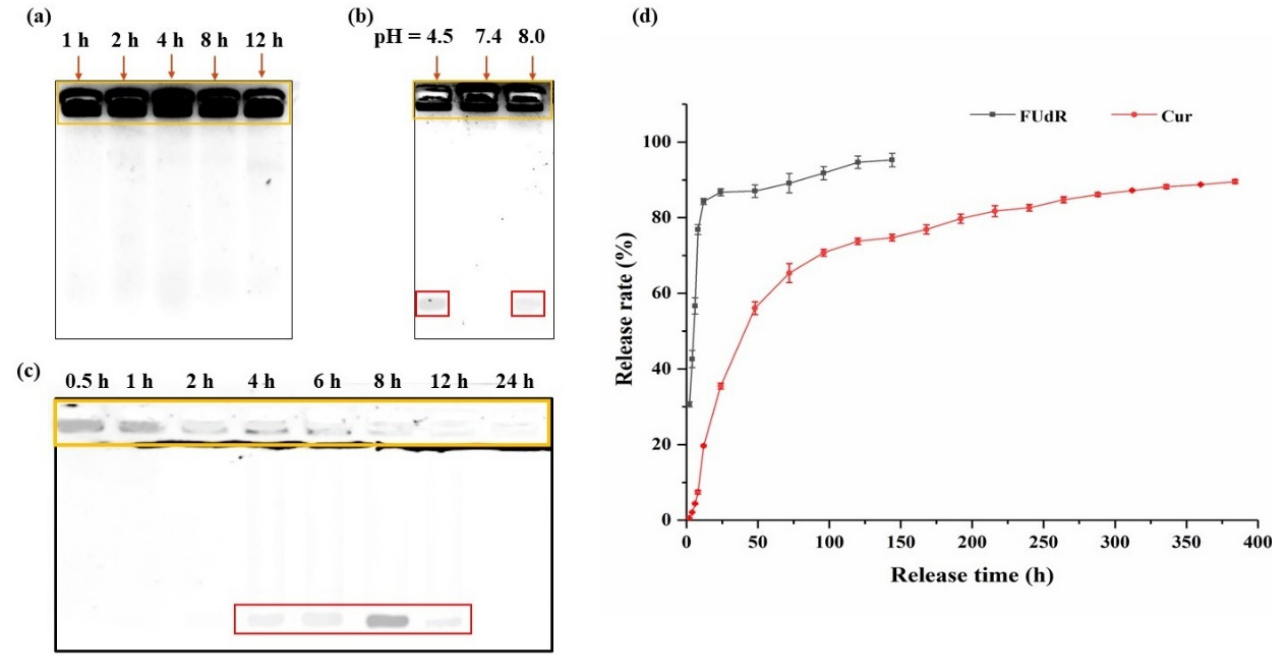
Figure 3. Stability and in vitro release of Cur@PHBX-PR/FUdR 15S . ( a ) Stability study of Cur@PHBX- PR/FUdR 15S in BSA. ( b ) Stability study of Cur@PHBX-PR/FUdR 15S at different pH levels. ( c ) Stability study of Cur@PHBX-PR/FUdR 15S in DNase II solution. ( d ) The release behavior of FUdR 15S and Cur at different time intervals. The orange box represents the undegraded Cur@PHBX-PR/FUdR 15S . The red box represents the FUdR 15S strand released from Cur@PHBX-PR/FUdR 15S . Data represented as mean ± SD (n = 3).